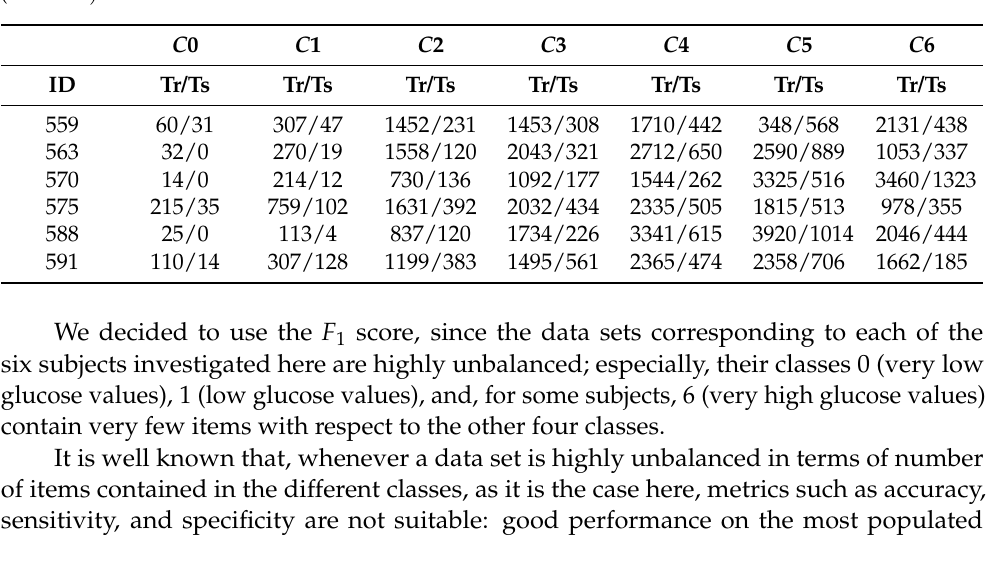
Figure 3. Classification bands on the testing set for each patient in the Ohio data set [83]. Table 4. The number of samples in the training/testing (Tr/Ts) sets for each patient ID and class ( C 0 ÷ C 6 )